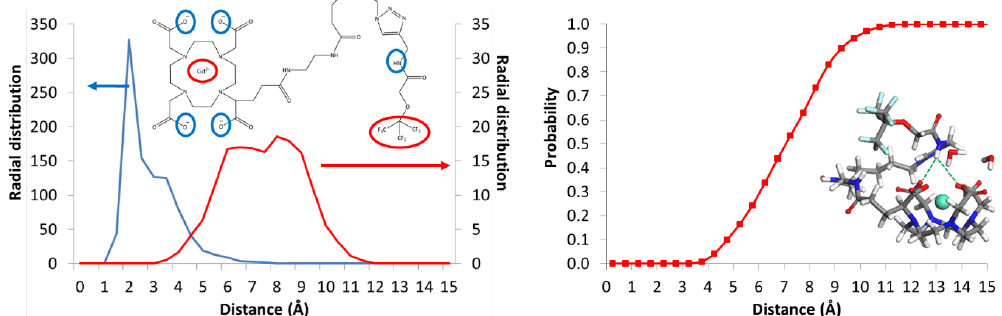
Figure 7. ( Left ) Radial distribution functions between (i) the fluorine atoms and the gadolinium center (red curve and red circles in the inset) and (ii) between the hydrogen atom of the amine function close to the terminal nonafluoro-tert-butyl ether and the negatively-charged oxygen atoms of the carboxylate groups of the DOTA ligand (blue curve and blue circles in the inset), as built from 1001 snapshots recorded during a 5-ns molecular dynamics (MD) run. ( Right ) Cumulative probability for the distance between the fluorine atoms and the gadolinium center as a function of their distance. Inset: a typical conformation of 7 a extracted from a MD run for which the hydrogen bonds between the hydrogen atom of the amine function close to the terminal nonafluoro-tert-butyl ether and the negatively-charged oxygen atoms of the carboxylate groups of the DOTA ligand are represented by green dashed lines.